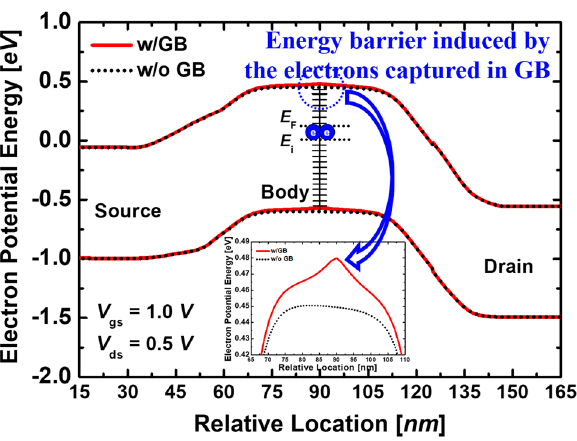
Figure 3. Electron potential energy of the proposed devices with and without GB at a read